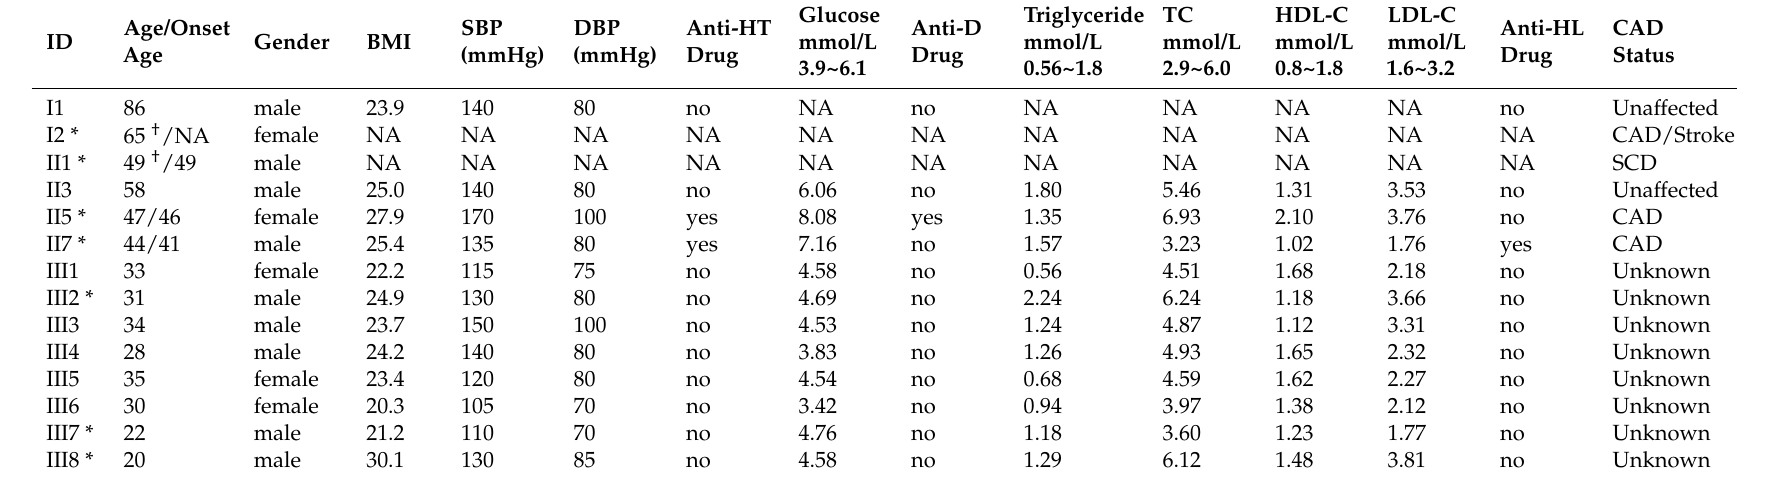
Table 1. Clinical characteristic of members with CAD